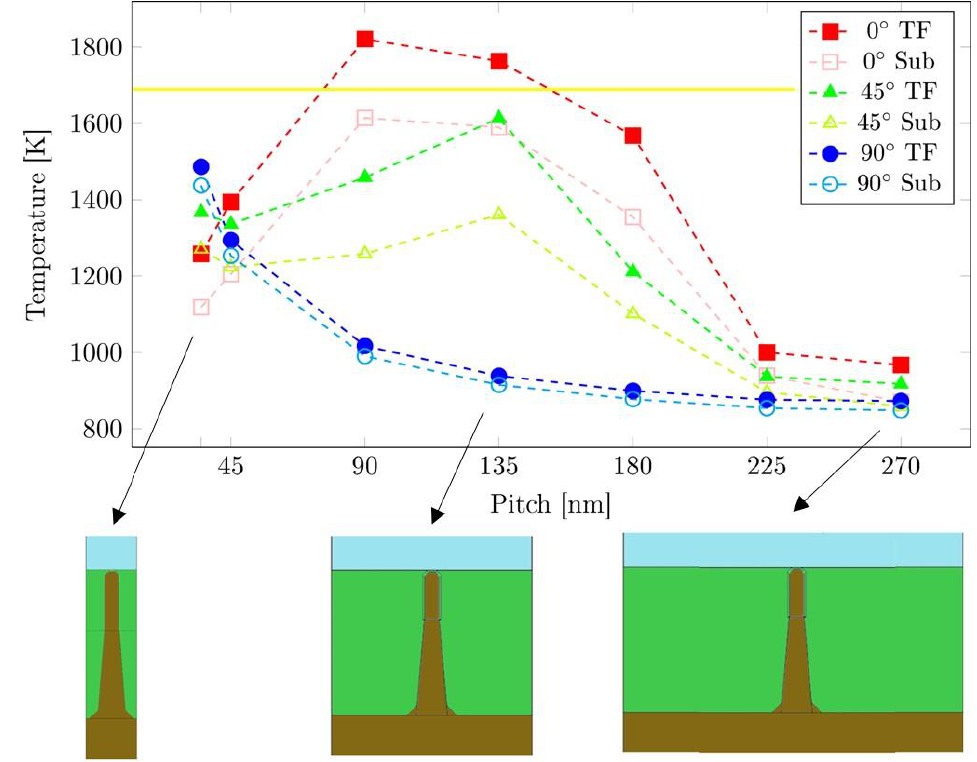
Figure 4. Maximum temperature (top panel) obtained in a thermal simulation of a ∆ t pulse = 160 ns PLA with 0.6 J/cm 2 energy density ( λ = 308 nm) in the top fin region (filled markers) and the substrate region (empty markers) of a FinFET array structure as a function of the pitch and the polarization of the laser light from Transverse Electric (TE = 0 ◦ ) to Transverse Magnetic (TM = 90 ◦ ). The bottom panel shows some systems with representative pitches (35 nm, 135 nm, 270 nm). Light blue, green, and brown indicates Air, SiO 2 and Si regions, respectively. The yellow line in the top panel indicates the melting threshold for Si.